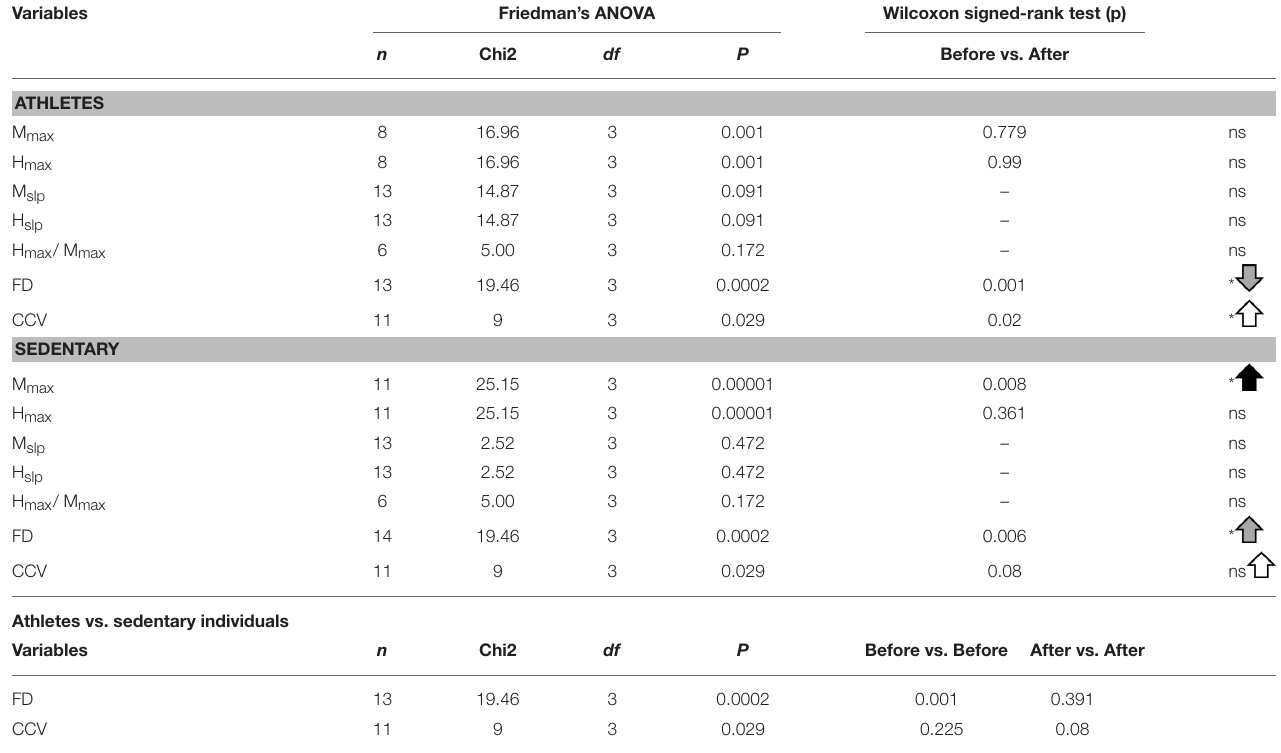
Athletes vs. sedentary individuals Variables n Chi2 P Before vs. Before After vs.